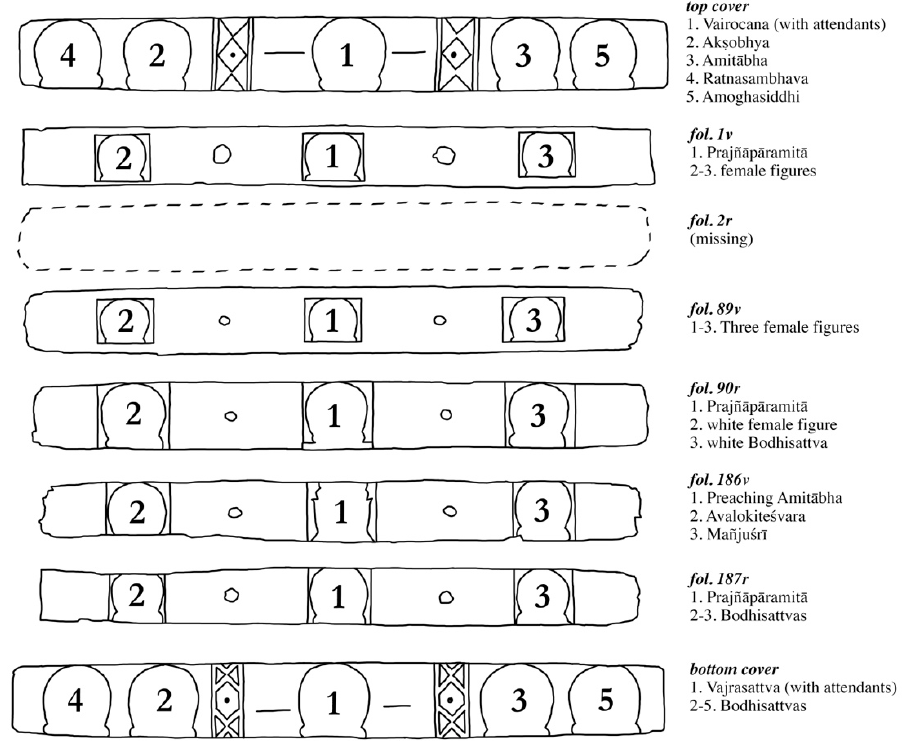
Figure 3. Chart shows the layout and iconography of the painted boards and palm leaves. Created by